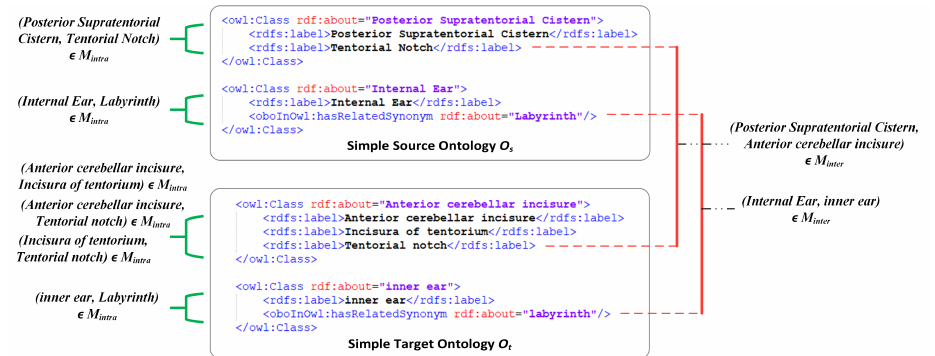
Figure 3. An example of constructing inter-intra candidate positive